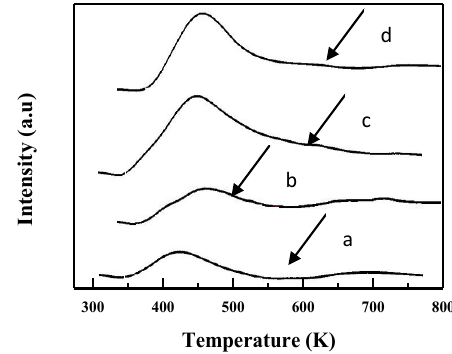
Figure 3. NH 3 -TPD profiles of ( a ) SiO 2 (pretreated at 600 °C for 2 h); ( b ) 2.9 wt% TiO 2 /SiO 2 -500; ( c ) 7.1 wt% Cr 2 O 3 -6.3 wt% NiO/SiO 2 -500; and (d) 1.4 wt% TiO 2 -6.1 wt% Cr 2 O 3 /SiO 2 -500.